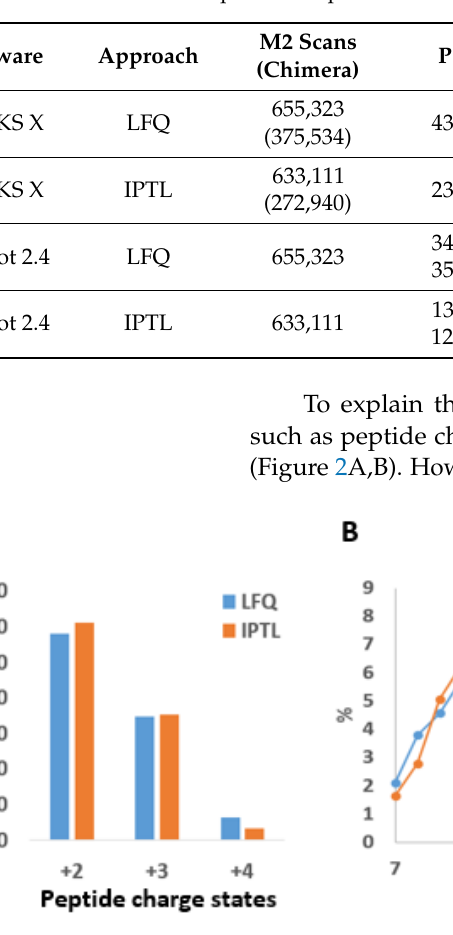
Table 1. Protein identification for LFQ and IPTL. Eight replicates for LFQ and IPTL were analyzed by LC–MS and proteins identified with PEAKS X and Mascot 2.4. The numbers of MS2 scans and peptide–spectrum matches (PSMs) are displayed. The number of chimera spectra is reported in PEAKS, and the identity and homology threshold is provided by Mascot 2.4.